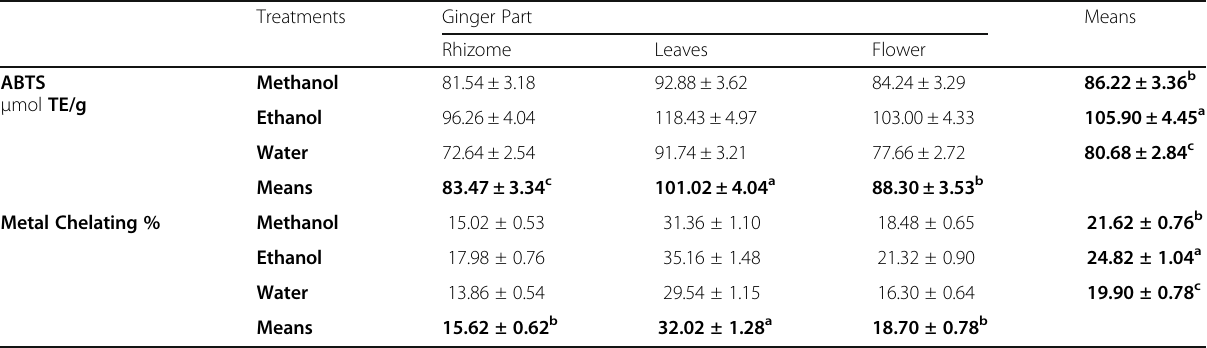
Table 4 Means for ABTS and metal chelating assay of ginger extract